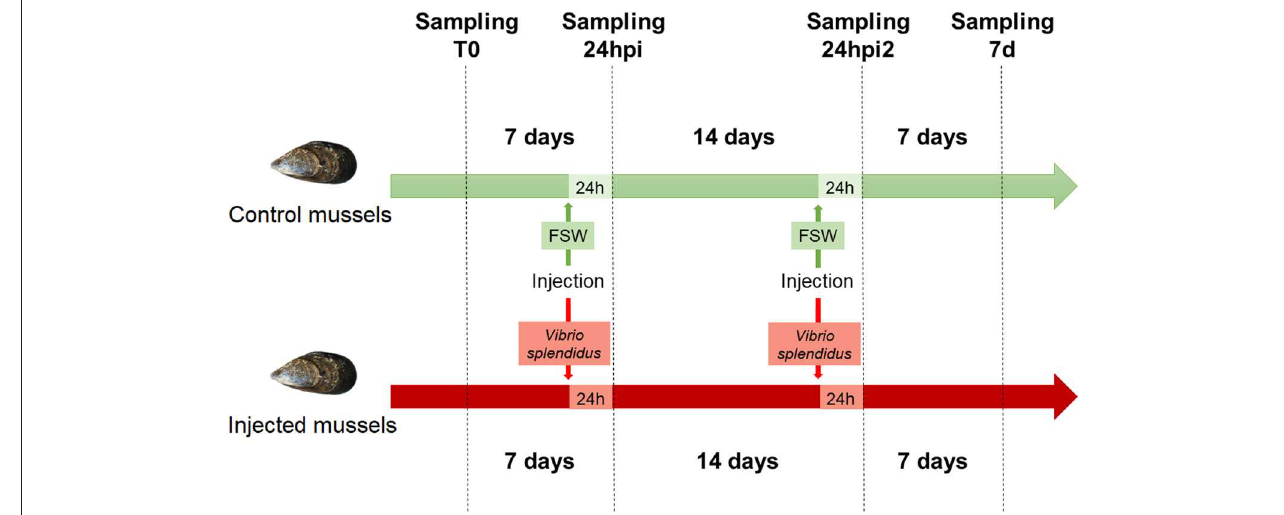
FIGURE 1 | Experimental design used for the stimulation of